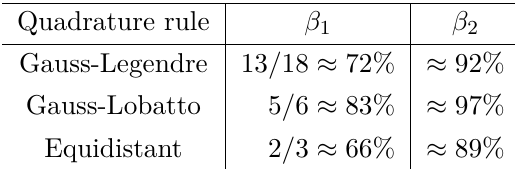
Table 1 . Approximate bounds on the probability for interval [Σ min , Σ max ]